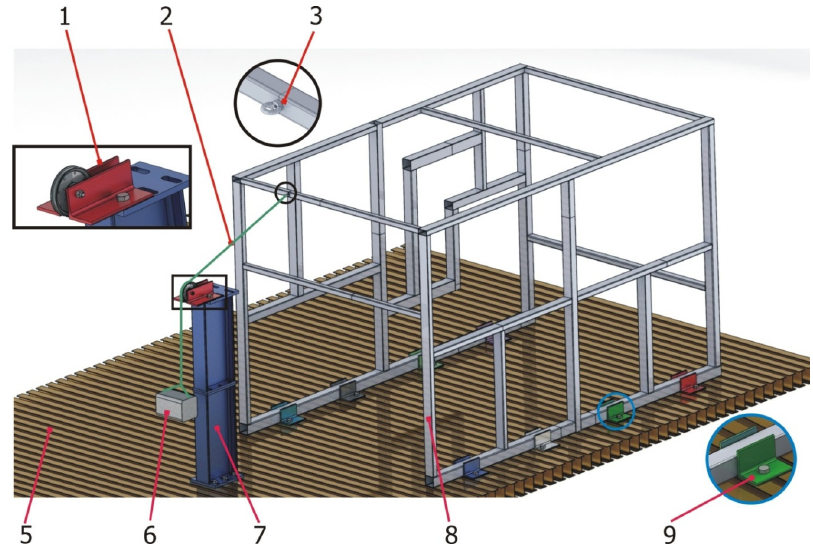
Figure 6. Three-dimensional CAD model with the characteristics of the experimental assembly corresponding to the testing of the validation structure.